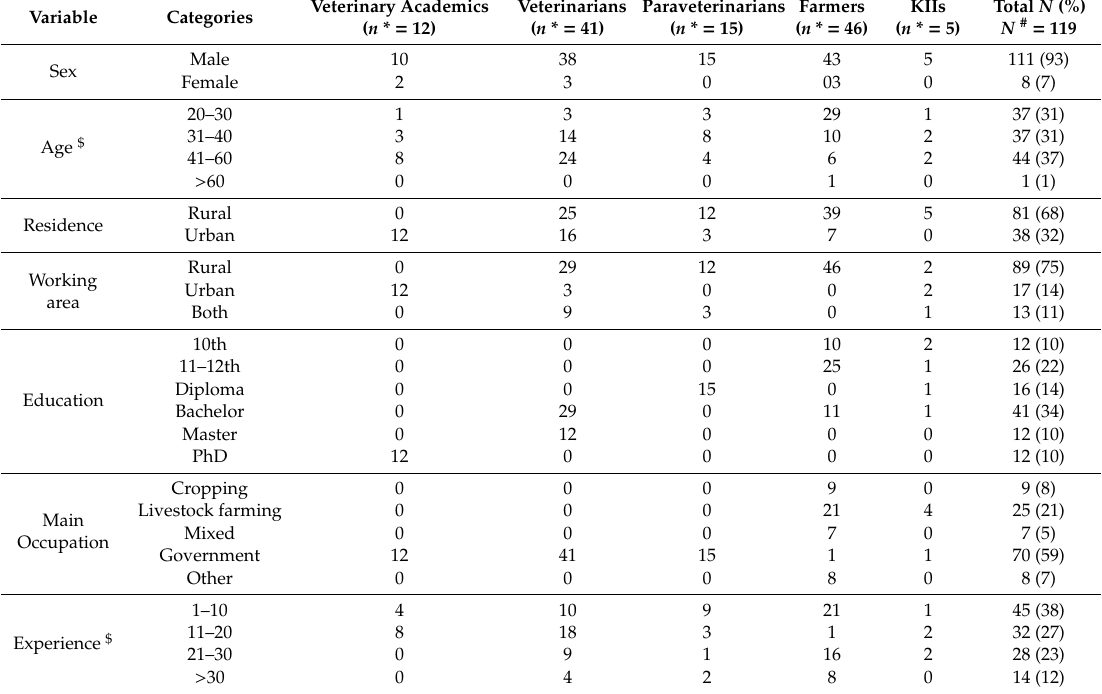
Table 1. Demographic characteristics of 119 stakeholders participating in seven focus group discussions (FGDs) and five key-informant interviews (KIIs) in the Punjab state of India in 2018–19.